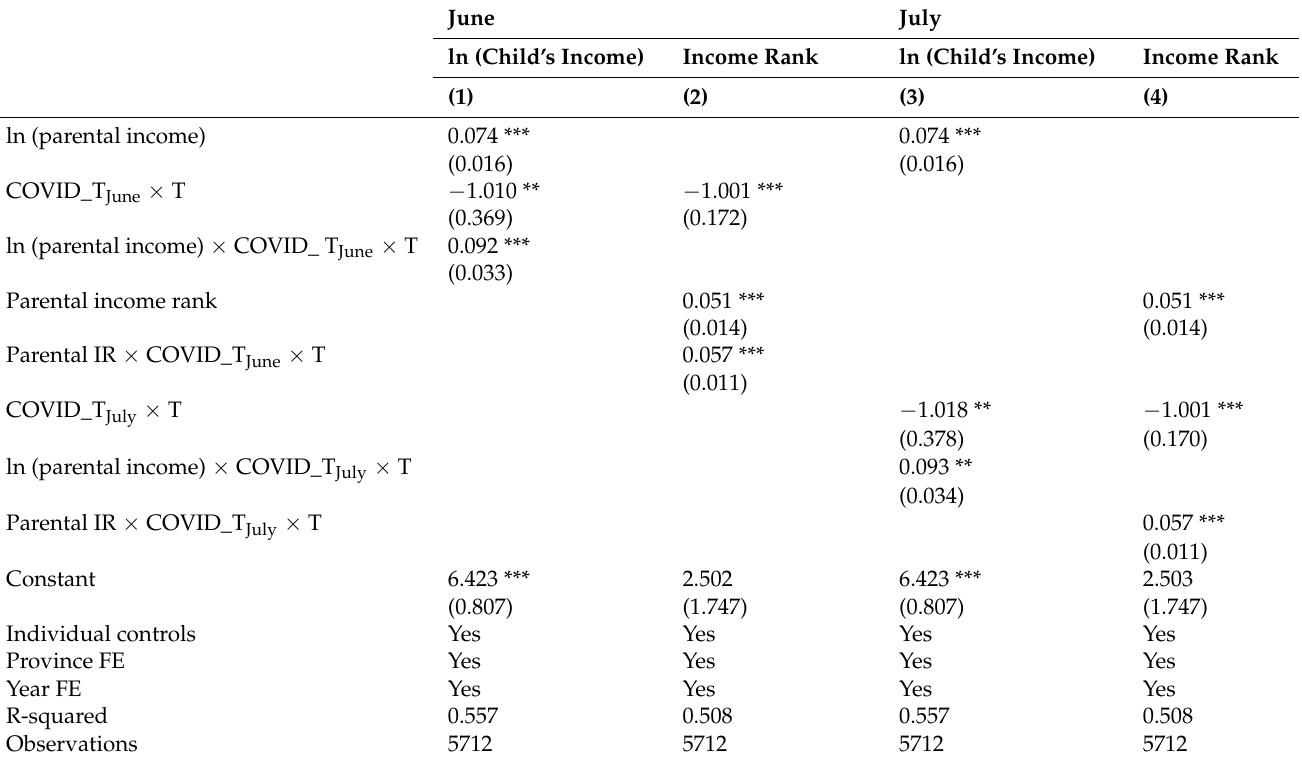
Table A3. Robustness: using COVID-19 intensity index calculated form June and July pandemic